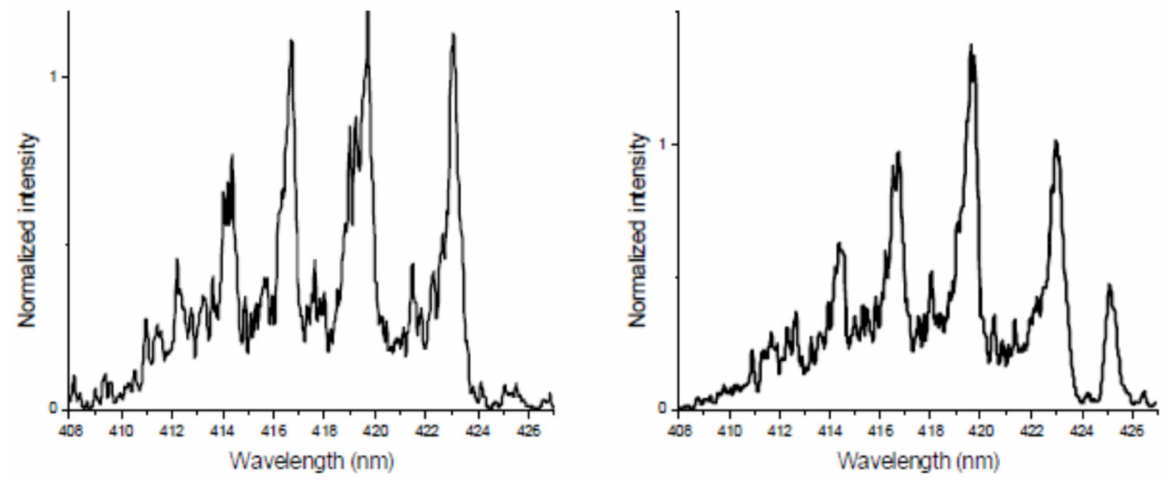
Figure 50. Spectrum of CN violet ∆ v = − 1 (Case 4 of Table 5): Left: Zone 1; Right: Zone 2 (from [52]).